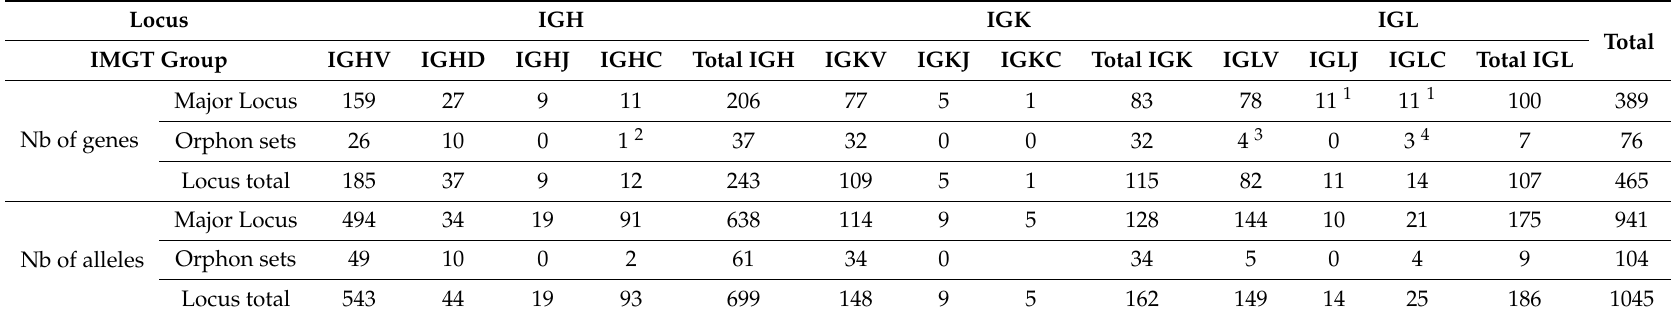
Table 5. Number of IG genes and alleles per IMGT group in IG major loci and orphon sets. Locus IGH IGK